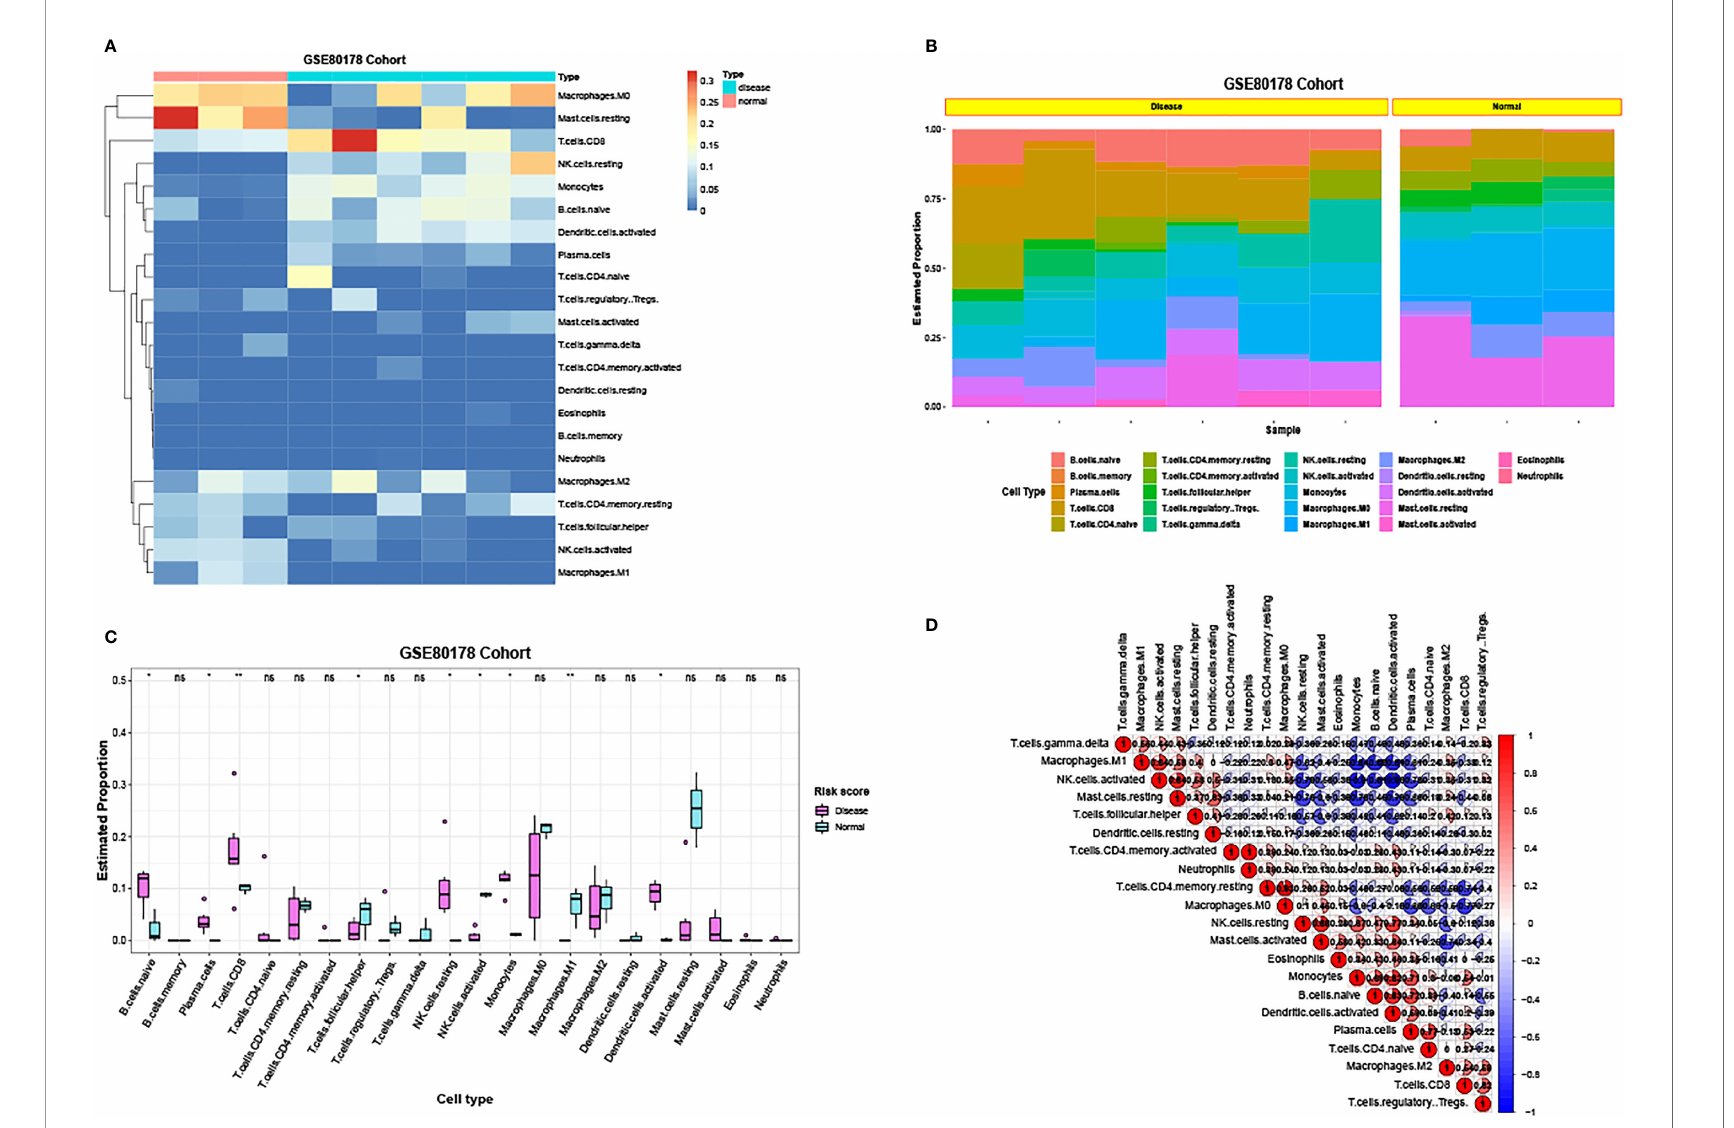
FIGURE 10 | The ratio of immune cells between standard samples and DFU samples. (A) Heatmap of the ratio of 22 immune cells between standard and DFU samples in GSE80178. (B) Histogram of the ratio of 22 immune cells between standard and DFU samples in GSE80178. (C) Box diagram of the ratio of 22 immune cells between standard and DFU samples in GSE80178. (D) Correlation of 22 immune cells in